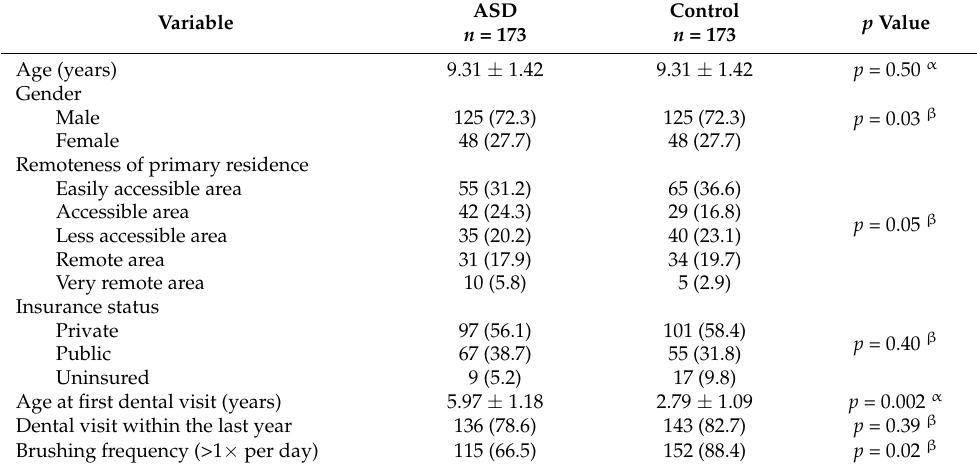
Table 1. Patient demographic characteristics and oral health behaviour n (%) or mean ± (SD).